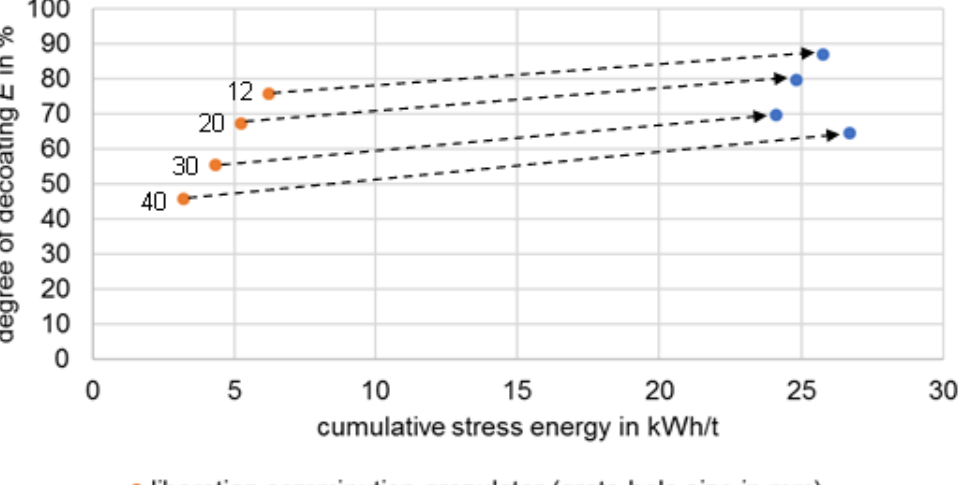
Figure 13. Dependence of decoating on stress energy.